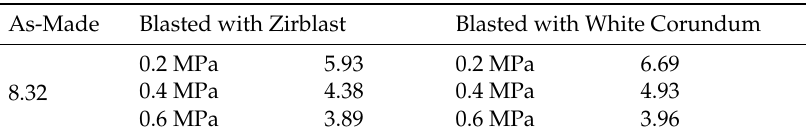
Table 7. p ‐ Values for the individual parameter. Table 7. p -Values for the individual